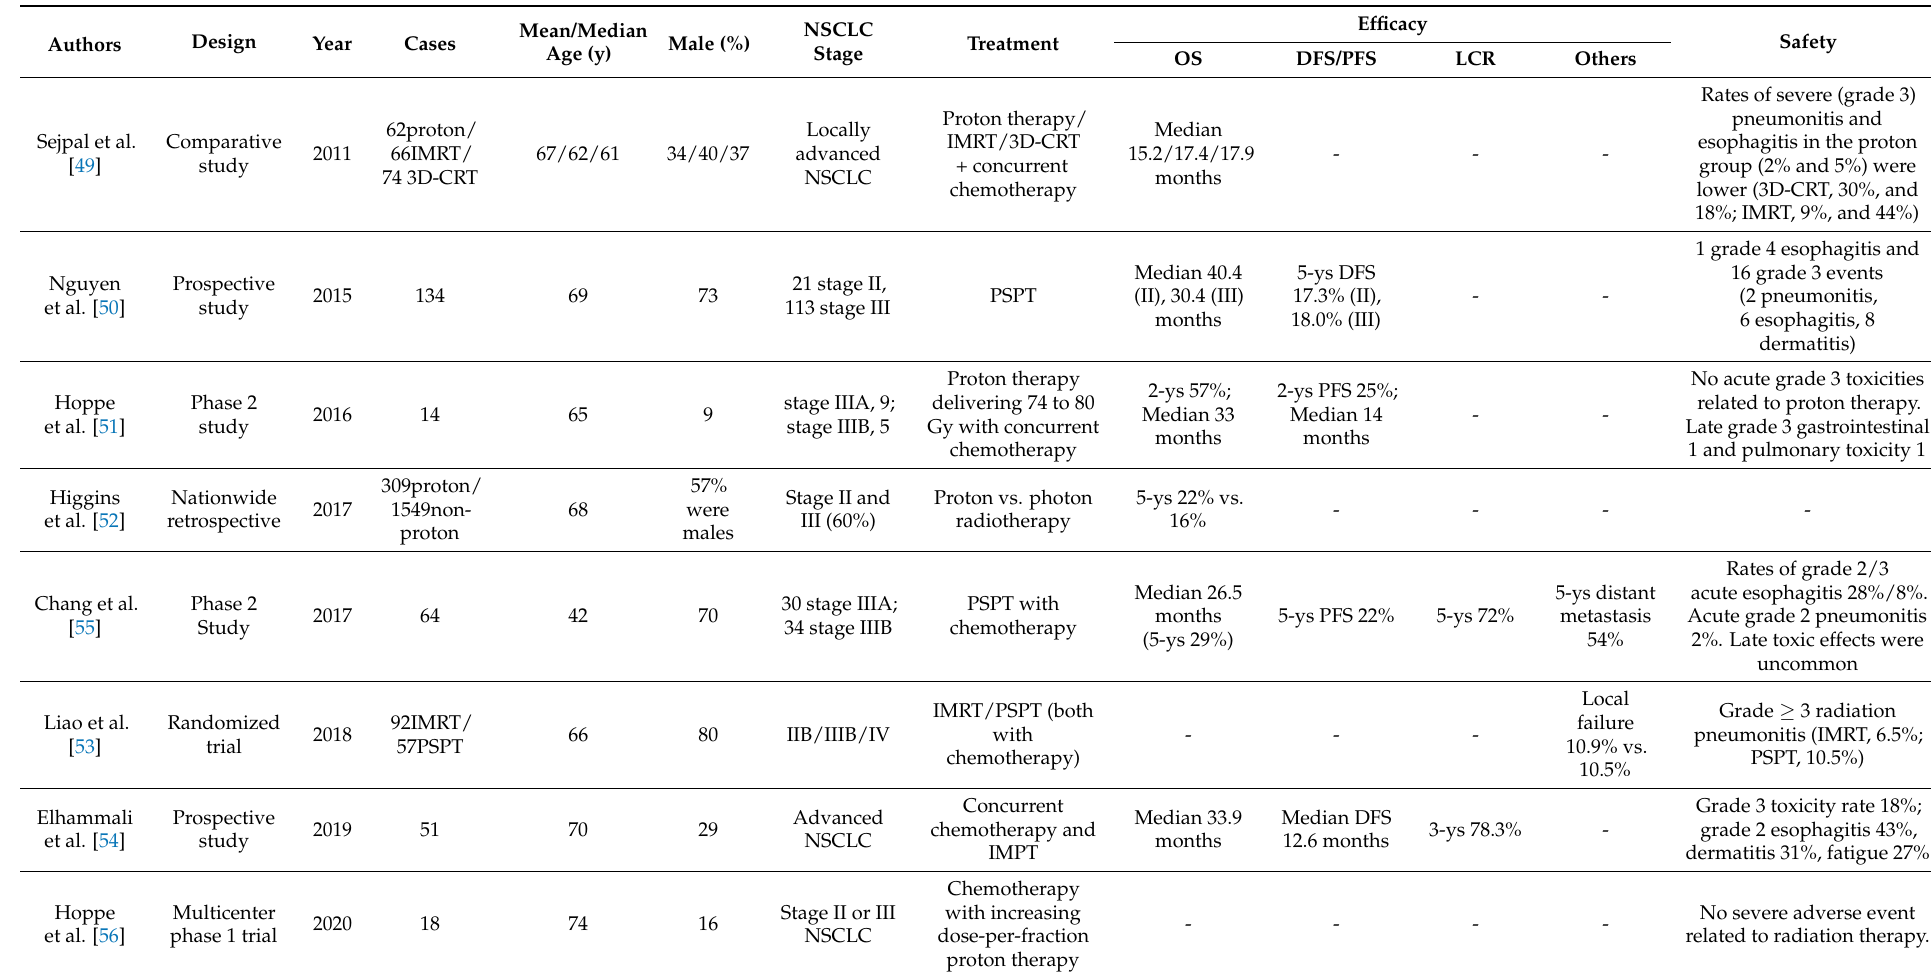
Table 3. Published prospective study/nationwide retrospective study involving proton therapy for locally advanced